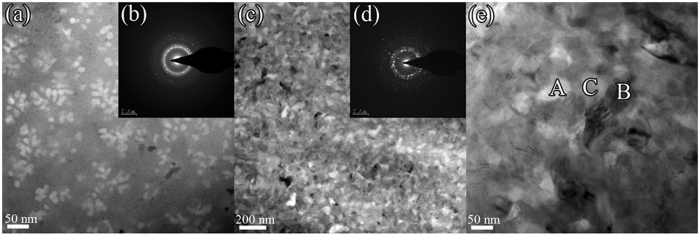
(a) Bright-field TEM image, (b) selected-area electron diffraction pattern of the 85Al alloy annealed for 300 s at a temperature just above the first exothermic peak, and (c) bright-field TEM image, selected-area electron diffraction pattern (d) and enlarged bright-field TEM image (e), of the Al84Y9Ni4Co1.5Fe0.5Pd1 initially fully glassy alloy annealed for 300 s at 580 K corresponding to the first exothermic peak. Areas A, B and C are identified as α-Al, AlxMy compound and residual amorphous phase respectively.